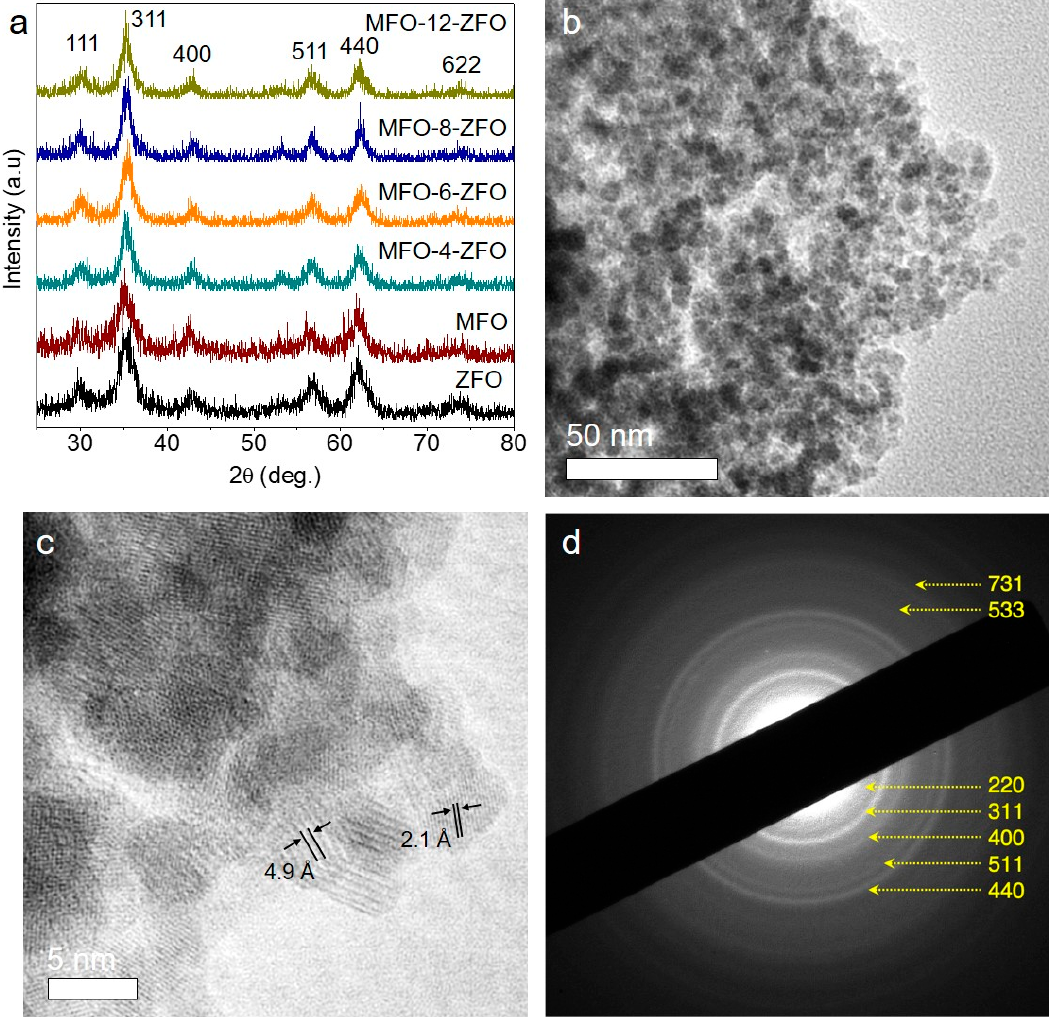
Figure 1. ( a ) Powder XRD patterns of ZFO, MFO, and MFO-ZFO MNAs. ( b ) Typical TEM, ( c ) high-resolution TEM (HRTEM), and ( d ) SAED pattern taken from a small area of mesoporous structure of the MFO-6-ZFO sample. In panel ( d ): All the diffraction rings are indexed to the cubic spinel structure of metal ferrites.